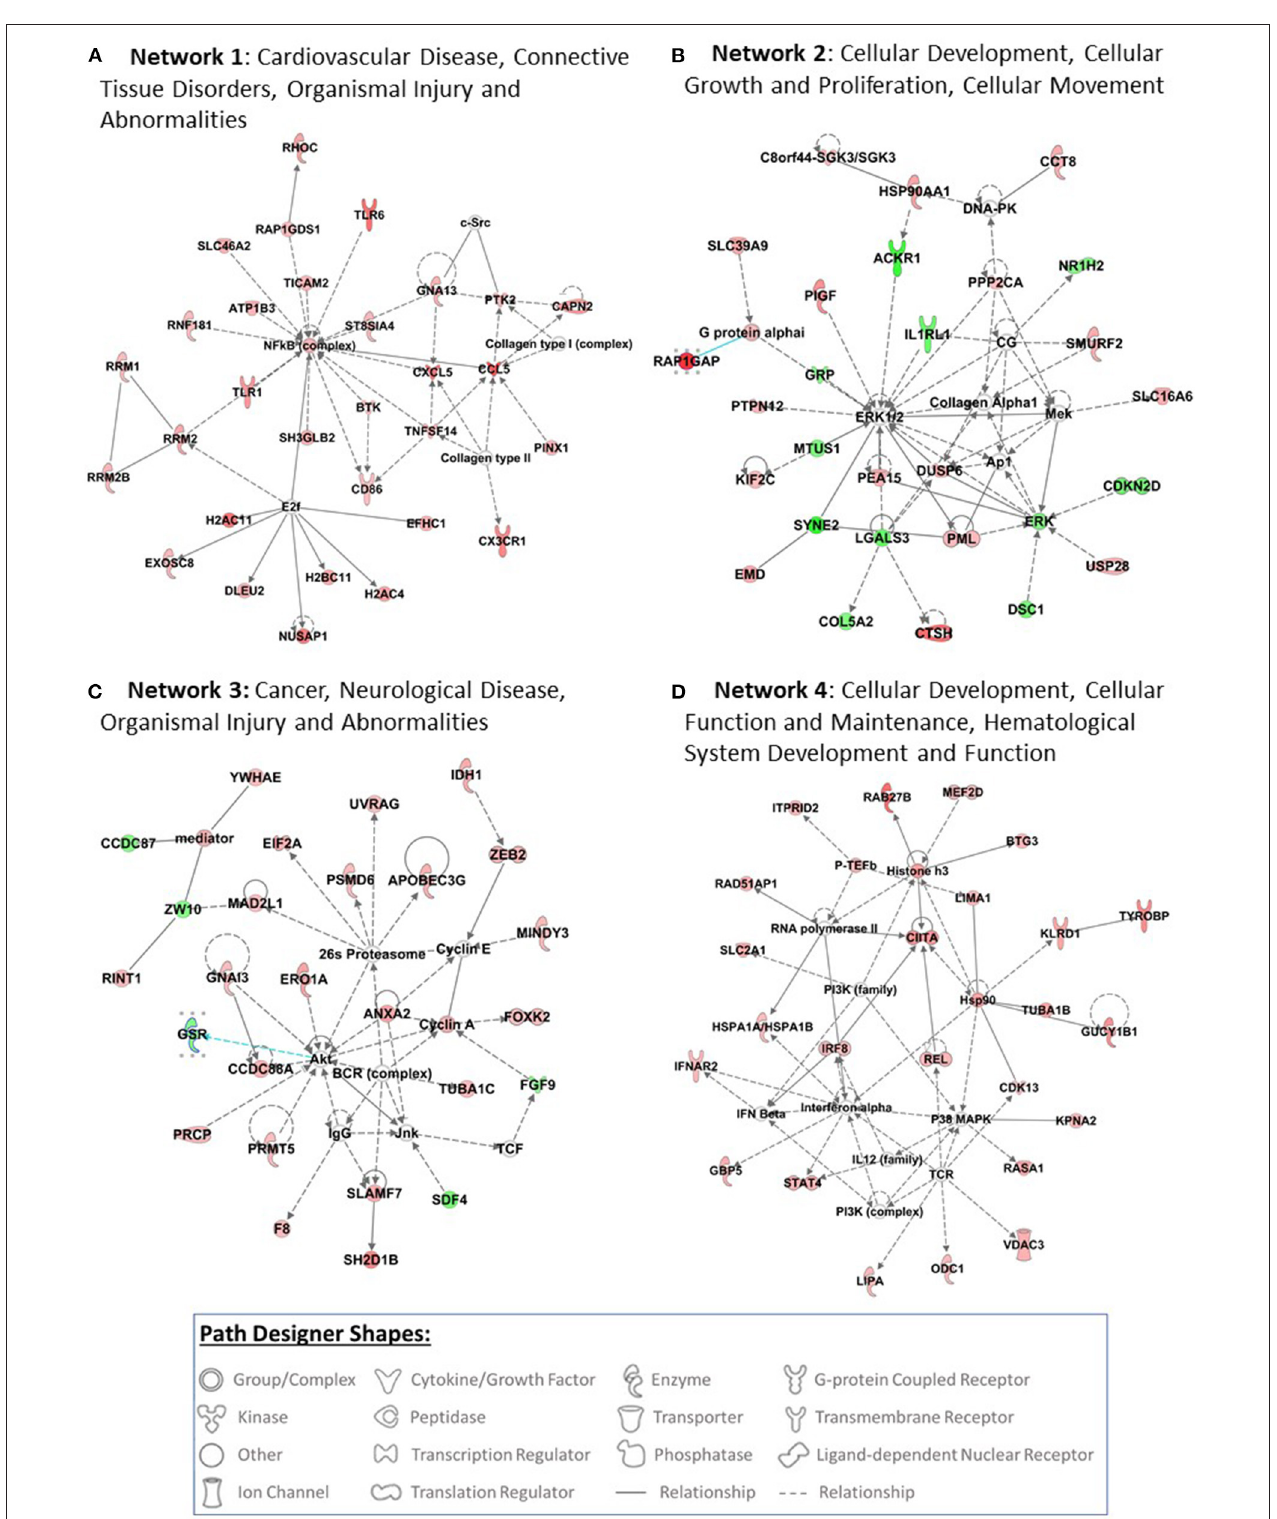
FIGURE 2 | Top 4 networks that are picked up by pathway analysis are presented in this figure (A–D) . Pathway analysis was performed using Ingenuity Pathway Analysis (IPA) software (QIAGEN Inc., https://digitalinsights.qiagen.com/IPA) by loading the 510 probe sets that were differentially expressed with exposure to COVID-19. The red filled path designer shapes are upregulated genes and green filled path designer shapes are downregulated genes after exposure to COVID-19.